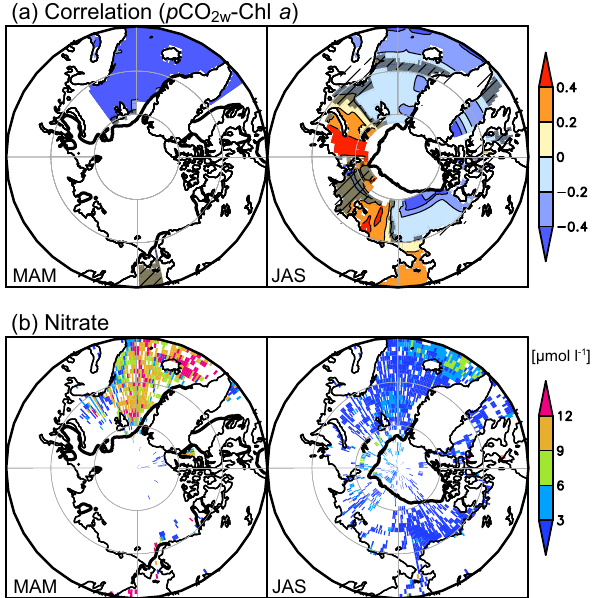
Figure 8. (a) Spatial correlation (correlation coefficient, r ) between p CO 2w and Chl a in a window size of ± 1 month, ± 5 ◦ lati- tude, and ± 30 ◦ longitude in March–May (left) and July–September (right). Darker hatched areas represent values in grids where corre- lations are insignificant ( P > 0.05). (b) Surface nitrate concentra- tion (µmolL − 1 ) in March–May (left) and July–September (right) from 1997 to 2014.